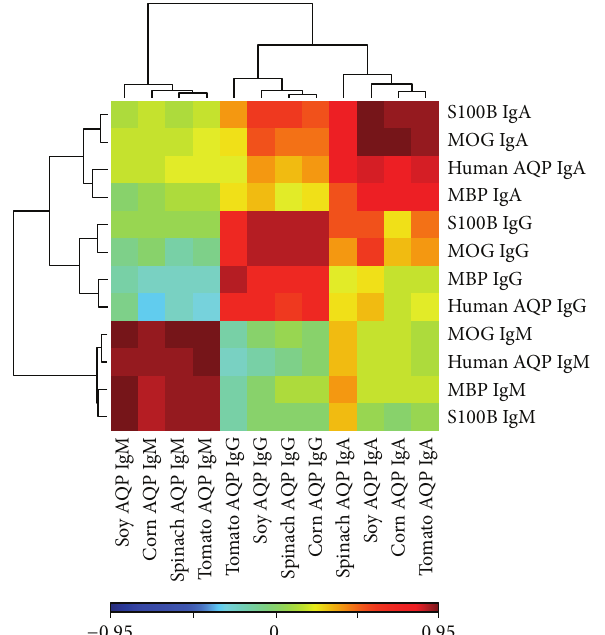
Figure 4: IgA, IgM, and IgG isotypes are clustered together with high correlations among the aquaporin peptides and brain proteins in each isotype.